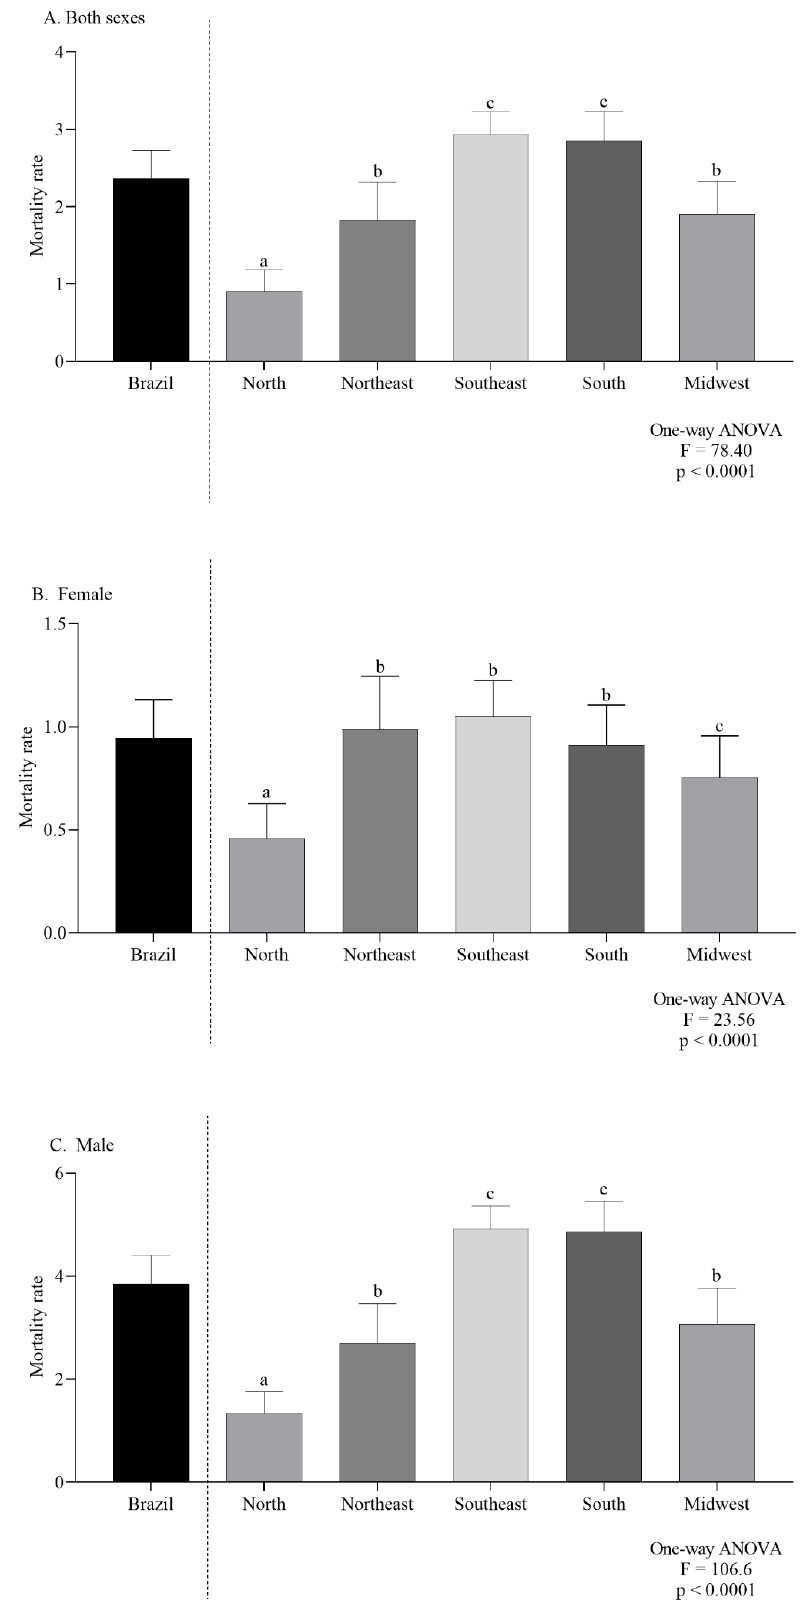
Figure 2. Overall mortality in Brazil, by regions, in Both sexes ( A ), females ( B ) and males ( C ). Lowercase letters indicate significant differences between regions ( p < 0.05, Dunn’s test).